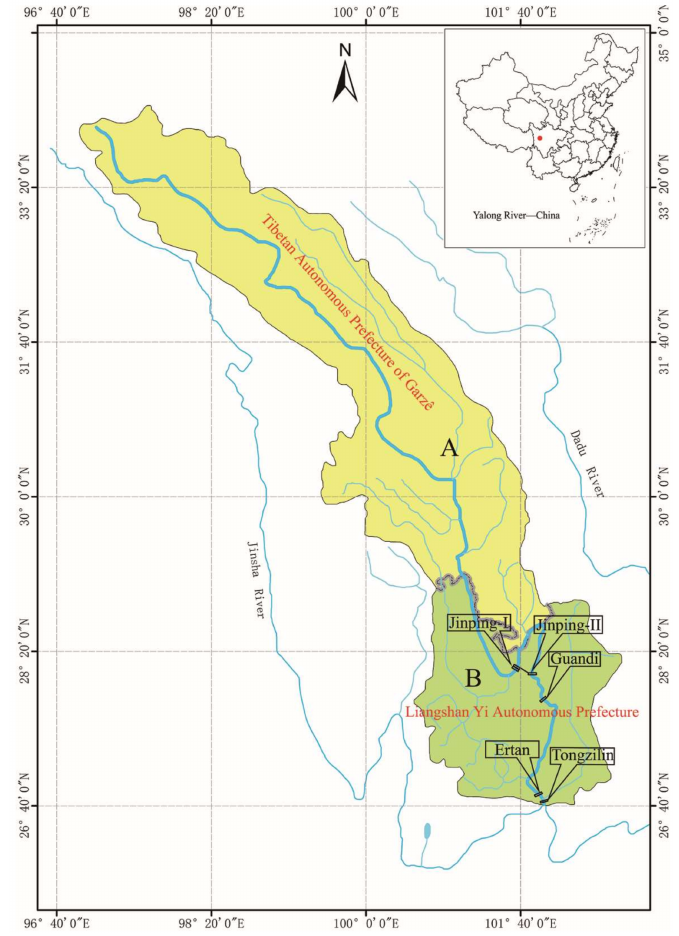
Figure 1. Topographic map of the study